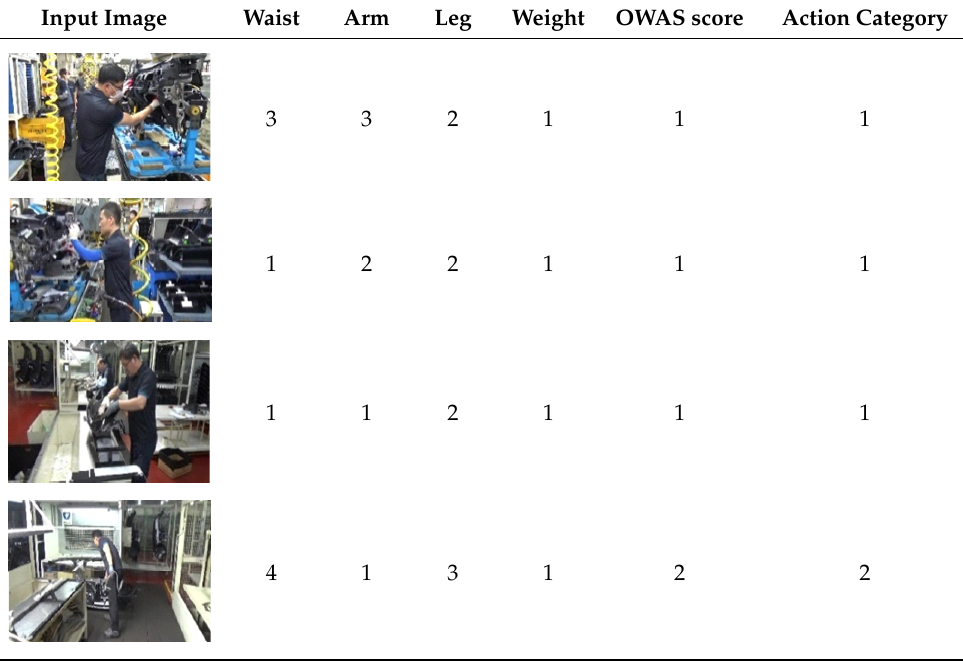
Table 2. Example of REBA score chart for input images.